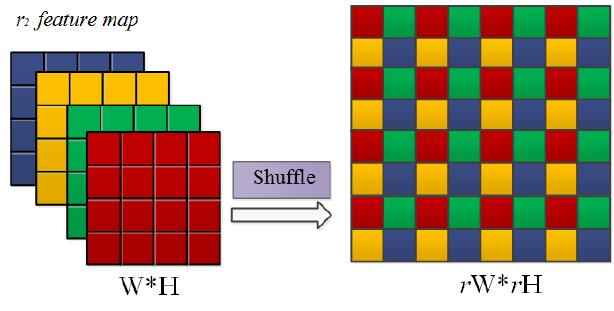
Figure 5. Sub-pixel convolution ( r =